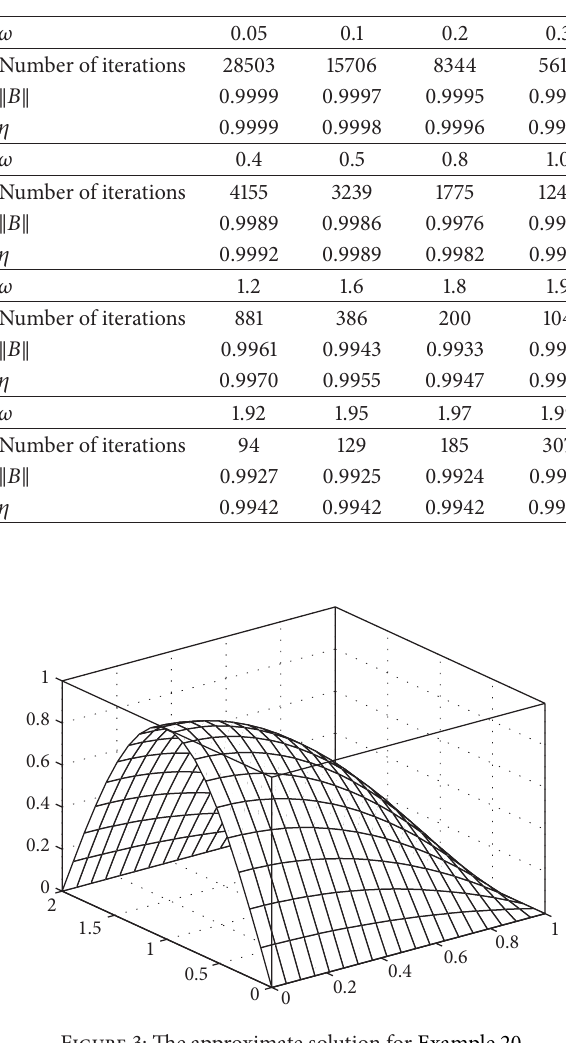
Table 2. The relation between the numbers of iterations